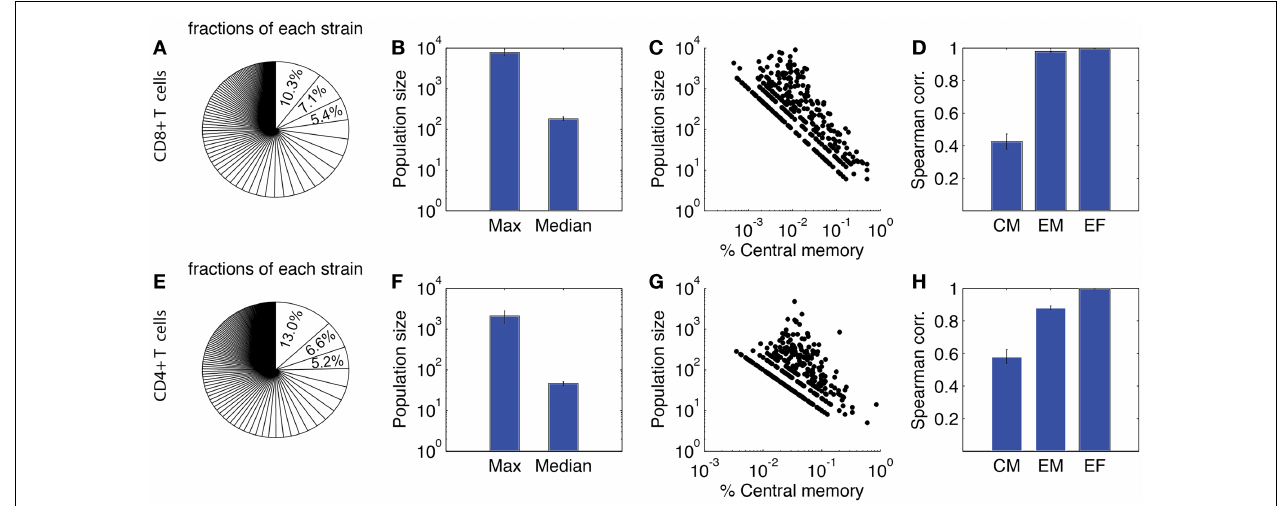
size and the percentage of central memory cells. Each dot represents progeny of a single-cell derived progeny. (D) Spearman correlation of CM, EM, and effector CD4 + T cell number versus total expanded population. (E–H) Prediction of CD4+T cell heterogeneity in clonal expansion.The four panels correspond to the same readouts as for panels A–D